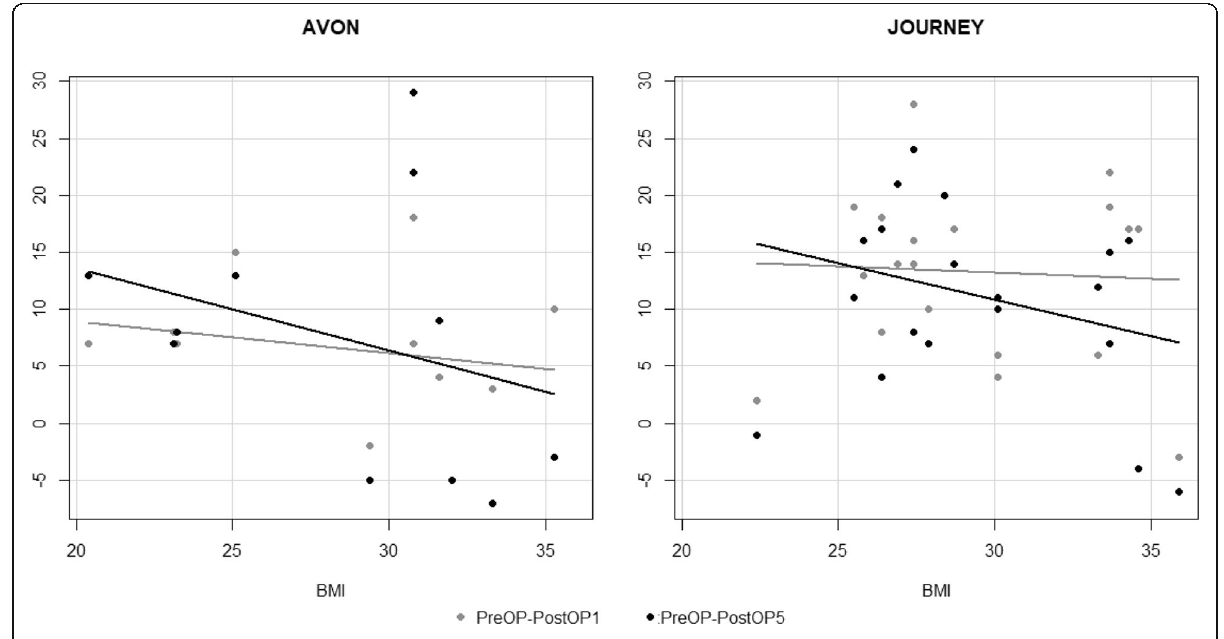
Fig. 5 Postoperative OKS improvement in relation to the BMI among the two different implant